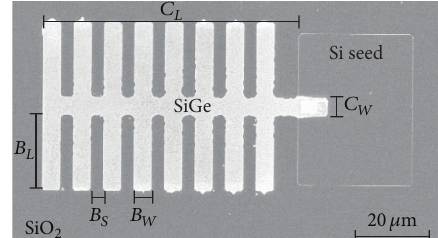
Figure 9: SEM image of a tailored tree-like structure. Dimensions are defined as follows: centre strip length C , branch width B , branch separation B length B L W